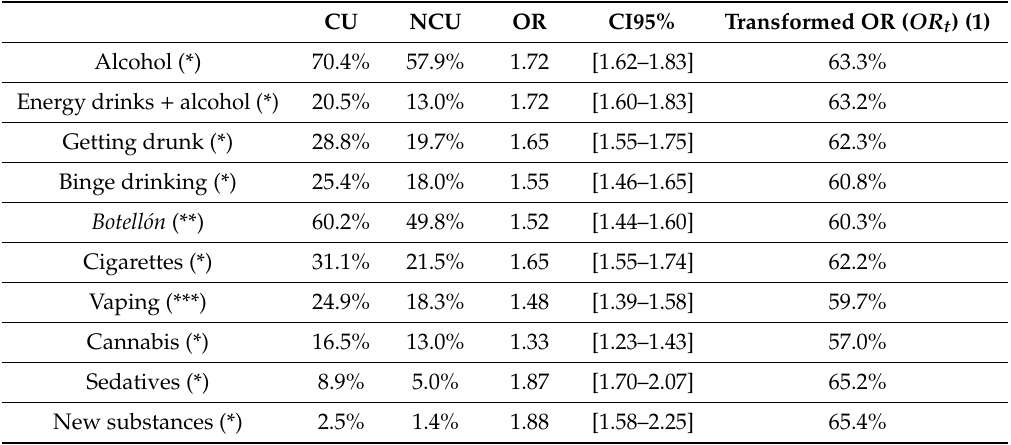
Table 6. Consumption by adolescents who display compulsive Internet use (CU) and those who do not